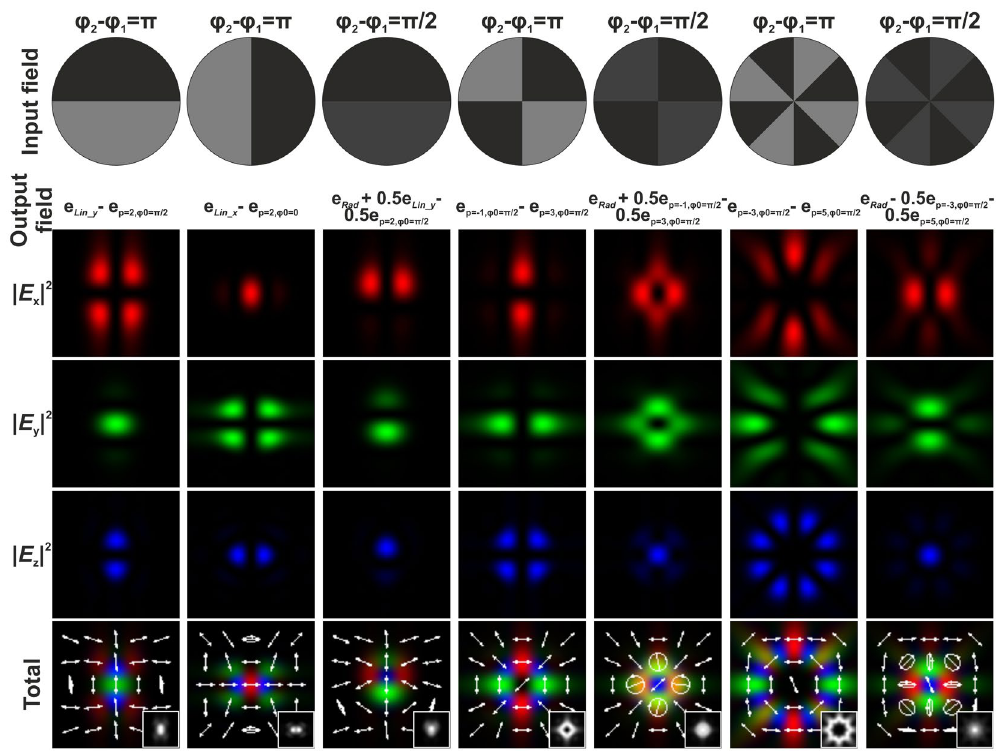
Figure 4. Transformation of the initial radially polarised laser beam passed through different binary multi- sector phase plates. In fact, the generated output fields are superpositions of different CVBs. The distribution of the various components of the electric field in the focal plane of a focusing system (NA = 0.99) are shown. The insets in the total field distribution images show the generated grayscale intensity distributions. The white arrows show the schematic polarisation